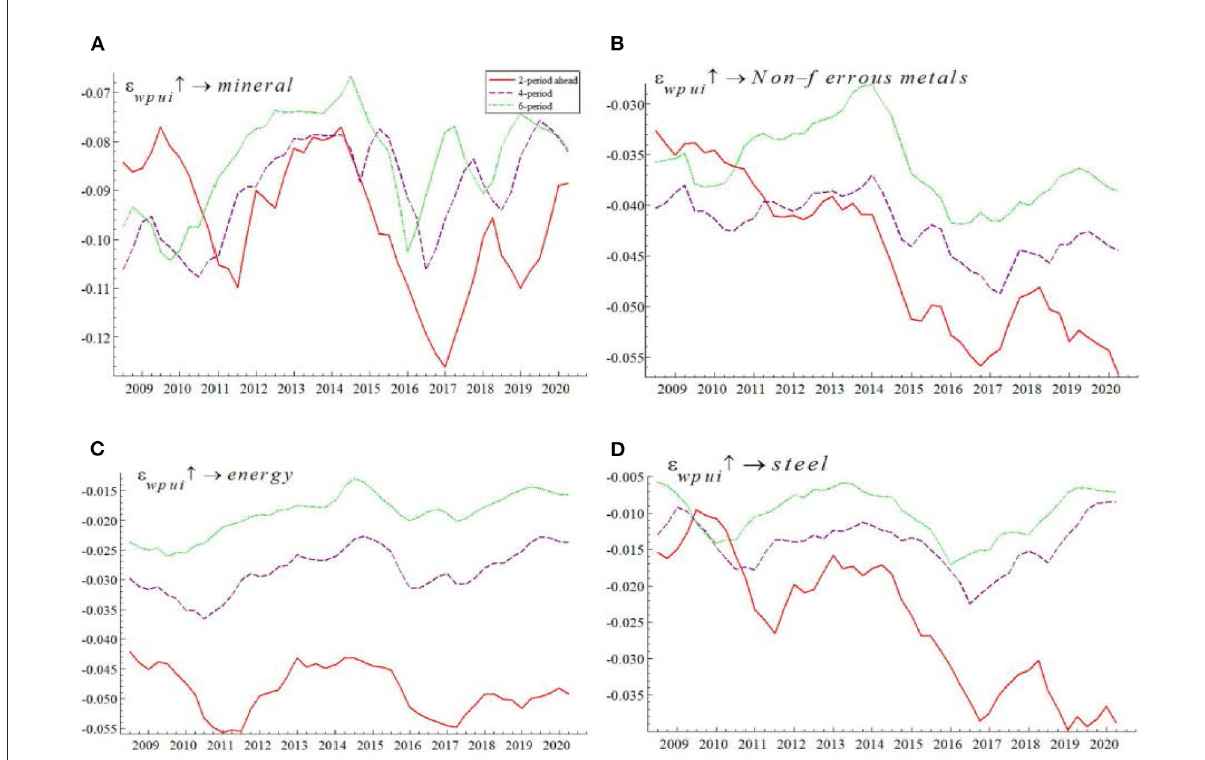
FIGURE5 Time-varying effects of WPU on the prices of different categories of commodities (i.e., (A) shows mineral, (B) shows non-ferrous metals, (C) shows energy, and (D) shows steel).